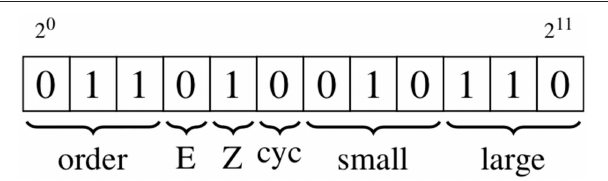
FIGURE 3 | Schematic showing the edge information, which is stored using 12 bits. The types of information are, from left to right: bond order of the associated bond; stereochemistry (E/Z) of the associated bond; whether the edge is part of a cycle with a size of up to eight; the smallest and largest degree of the vertices on either side of the edge. The numeric values of the bond order and degree are converted to binary format; the binary encodings of the stereochemistry and cycle indicators are described in the